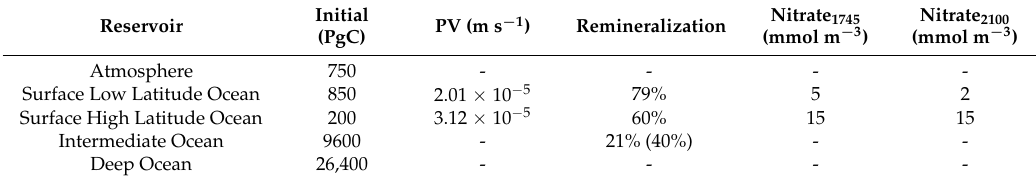
Table A4. Parameterization values prescribed for Excel-Hector in each reservoir: atmosphere, surface low latitude, surface high latitude, intermediate, and deep ocean. Values include in order: initial carbon (PgC), piston velocity (m s − 1 ), remineralization percentages, nitrate concentrations in the year 1745 (mmol m − 3 ), and nitrate concentrations in the year 2100 (mmol m − 3 ). The two percentages included for the intermediate remineralization represent: SLL to intermediate ocean and (SHL to intermediate